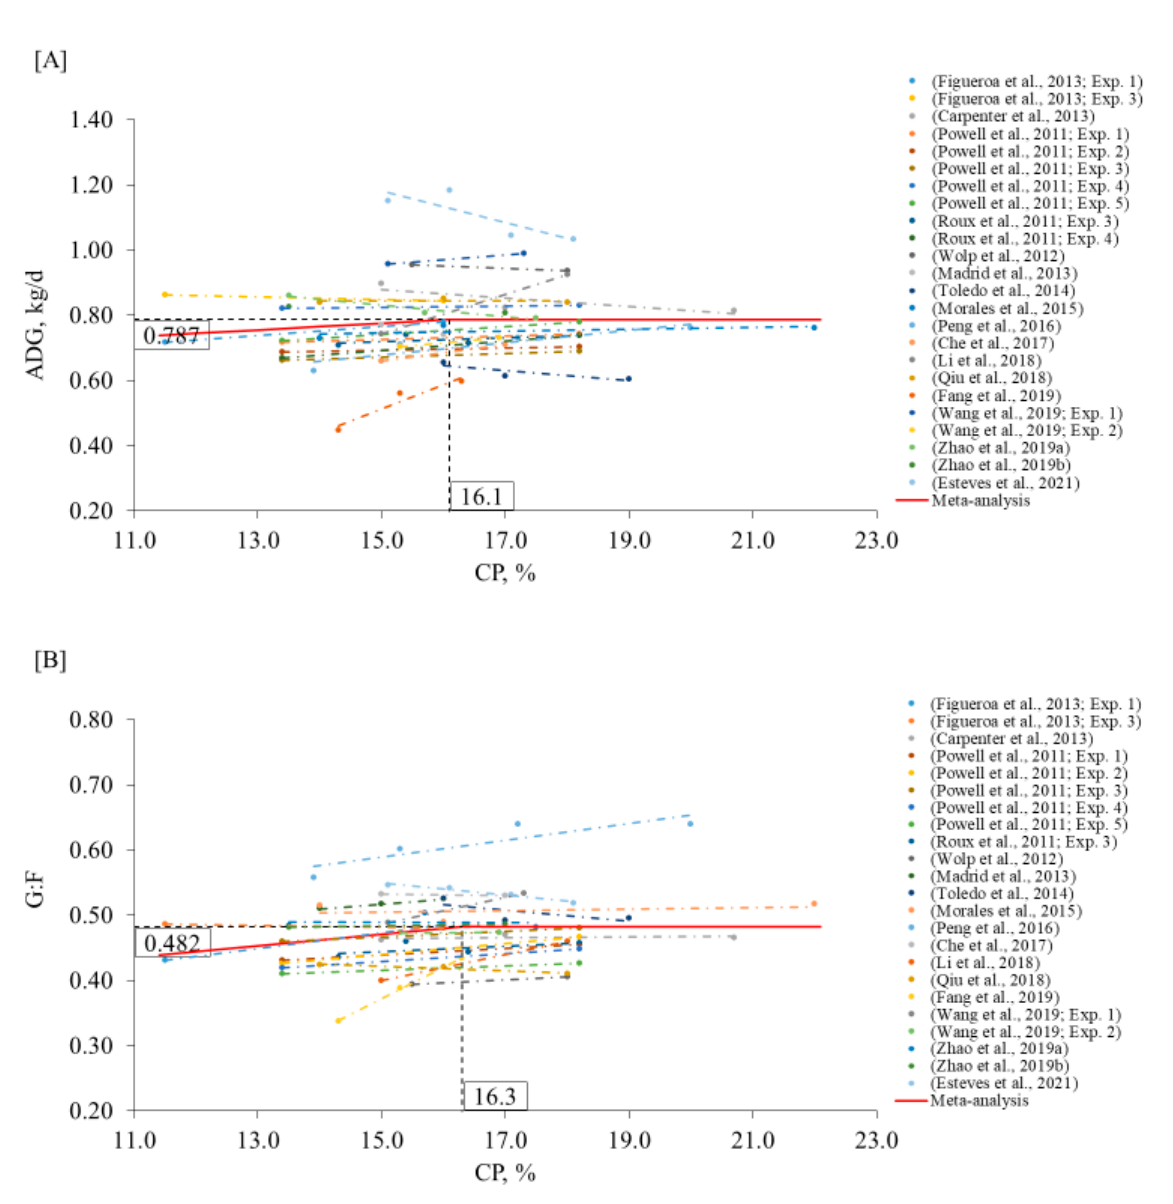
Figure 4. Changes in ADG ( A ) and G:F ( B ) in response to dietary CP in the growing phase using a broken-line analysis. The equation for ADG was ADG = 0.787 − 0.010 × zl (R2 = 0.93) and the breakpoint was CP level at 16.1% (95% CI: 16.0–16.2) when ADG was 0.787 kg/d. The p -value for the asymptote was <0.001, for the slope it was 0.050, and for the breaking point it was <0.001. The CI: 14.5–18.0) when G:F was 0.482. The p -value for the asymptote was <0.001, for the slope it